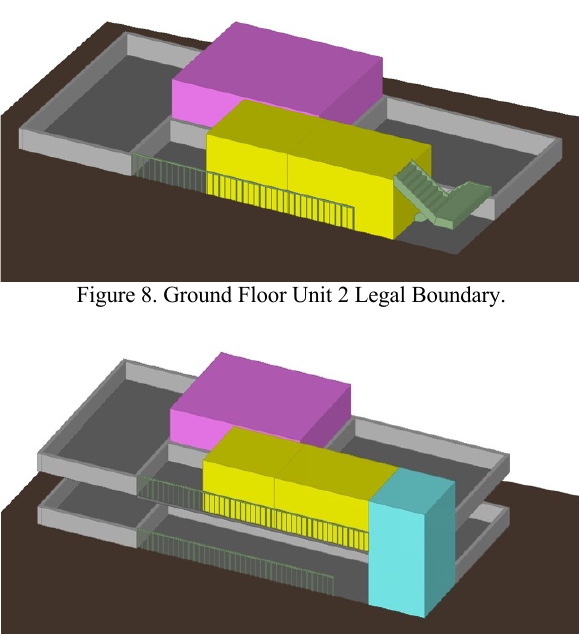
Figure 9. First Floor Unit 2 Legal Boundary.